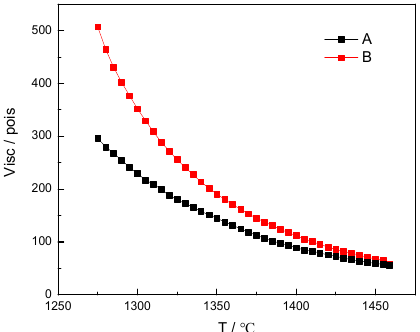
Figure6. Themeasuredviscositiesofbasaltandimitationbasaltcompoundsasafunctionoftemperature: Figure 6. The measured viscosities of basalt and imitation basalt compounds as a function of ( A ) basalt; ( B ) red mud imitation basalt temperature: ( A ) basalt; ( B ) red mud imitation basalt compound.